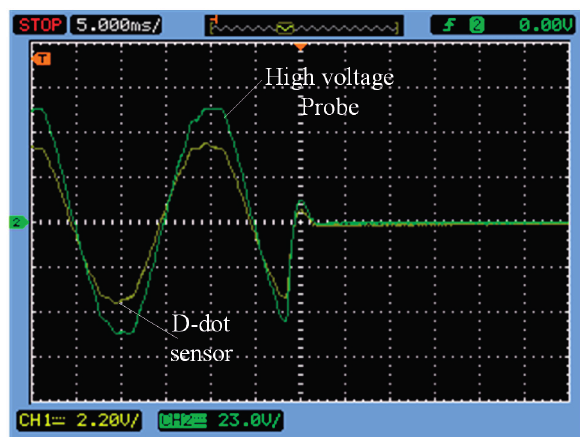
Figure 13. Transient waveform in the switching